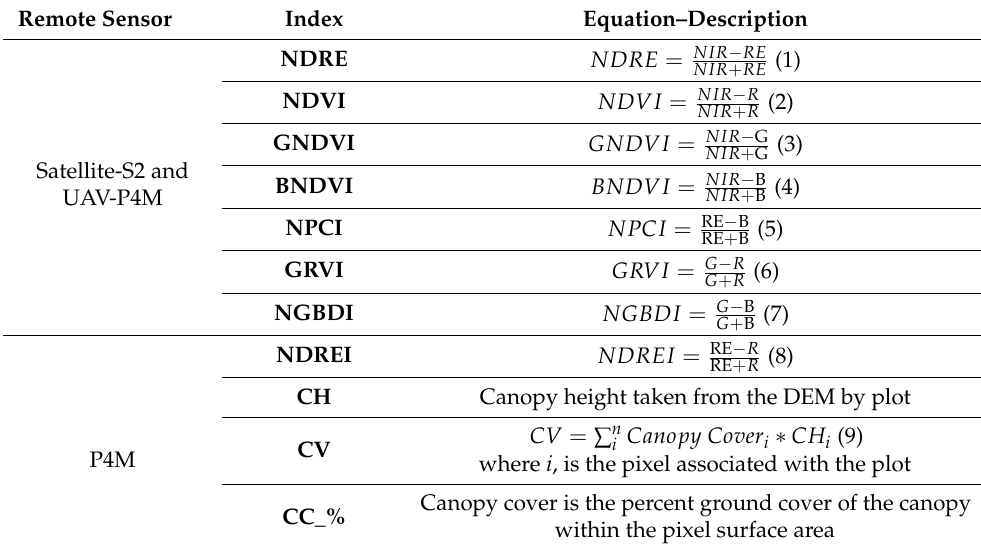
Table 3. VIs and canopy parameters using satellite and UAV remote